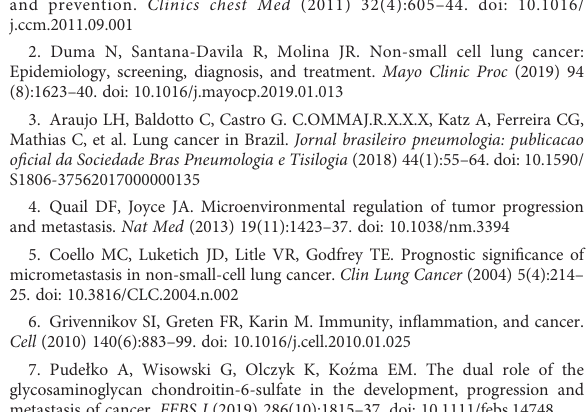
SUPPLEMENTARY FIGURE 1 Negative controls of immuno fl uorescence for E-cadherin and b -catenin in the different histological subtypes of NSCLC. The stained nuclei are represented in blue (DAPI). Original magni fi cation: 40X. LCC, large cell carcinoma; ADC, lung adenocarcinoma; SqCC: lung squamous cell carcinoma. SUPPLEMENTARY FIGURE 2 Negative controls of immuno fl uorescence for chondroitin sulfate and heparansulfate(green),andcollagentypesI,III,IV,andV(red).Thestained nuclei are represented in blue (DAPI). Original magni fi cation: 40X. SUPPLEMENTARY FIGURE 3 Survival curve for SPARC expression. The blue line represents the high expression of SPARC, and the yellow line the low expression of SPARC. SUPPLEMENTARY FIGURE 4 mRNA expression of the interest markers in lung adenocarcinoma from data obtained from “ The Cancer Genome Atlas ” (TCGA). **P<0.01. ADC, lung adenocarcinoma; Col, collagen type. SUPPLEMENTARY FIGURE 5 mRNA expression of the interest markers in lung squamous cell carcinoma from data obtained from “ The Cancer Genome Atlas ” (TCGA). **P<0.01. SqCC: lung squamous cell carcinoma; Col, collagen type. SUPPLEMENTARY FIGURE 6 Expression of the interest proteins in adenocarcinoma fromdata obtained from the Clinical Proteomic Tumor Analysis Consortium (CPTAC). *P<0.05, **P<0.01. ADC, lung adenocarcinoma; HS, heparan sulfate; CS, chondroitin sulfate; Col, collagen type. SUPPLEMENTARY FIGURE 7 Kaplan Meier curves for our interest markers obtained in KM-Plotter data base. The black line represents a low expression of the marker and the red line, the high expression. SUPPLEMENTARY FIGURE 8 Metascape enrichment analysis. (A) Heatmap of enriched terms across input gene lists. (B) Network formed by these enriched terms. (C) Biological processes were involved the gene list colored according to the